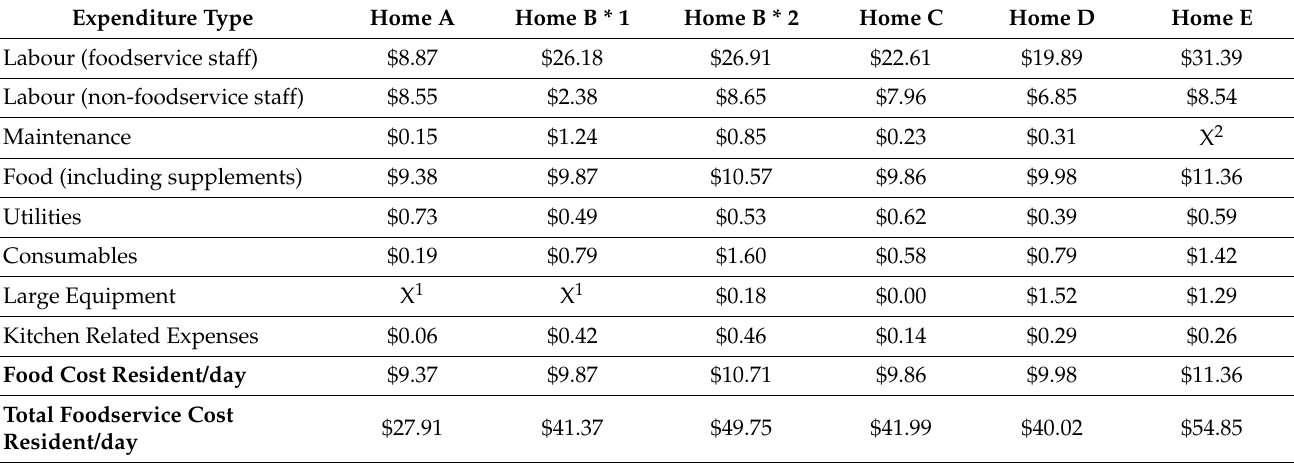
Table 5. Total expenditure across each FCT domain